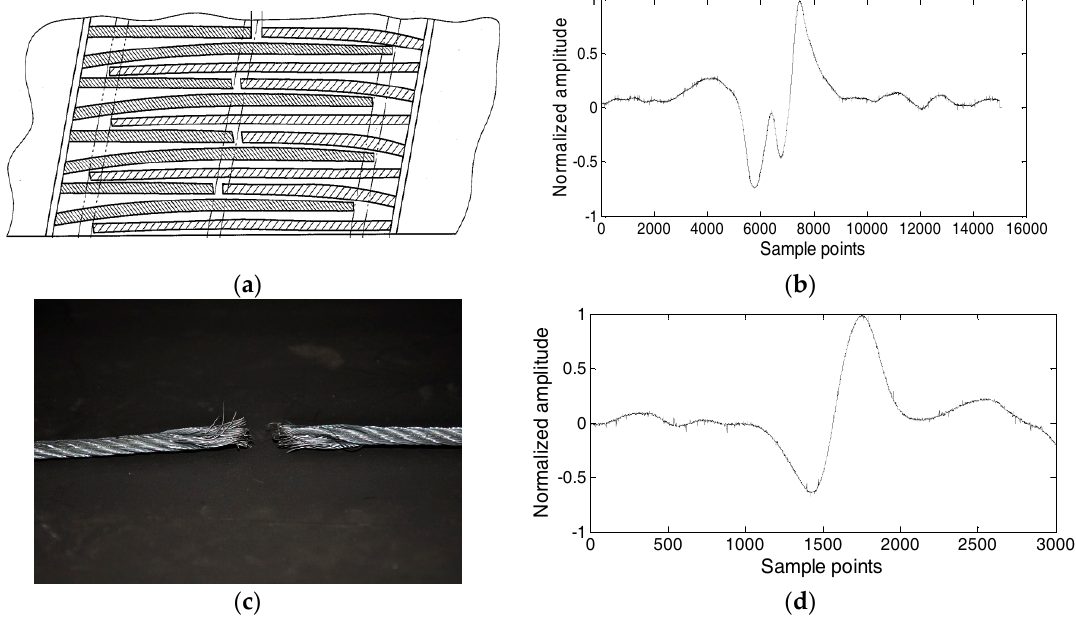
Figure 7. Joint and break of steel cord conveyor belt and responding electromagnetic signal: ( a ) Internal structure of conveyor belt joint; ( b ) Electromagnetic signal at joint; ( c ) Steel wire rope break of belt; ( d ) Electromagnetic signal of wire rope break defect.